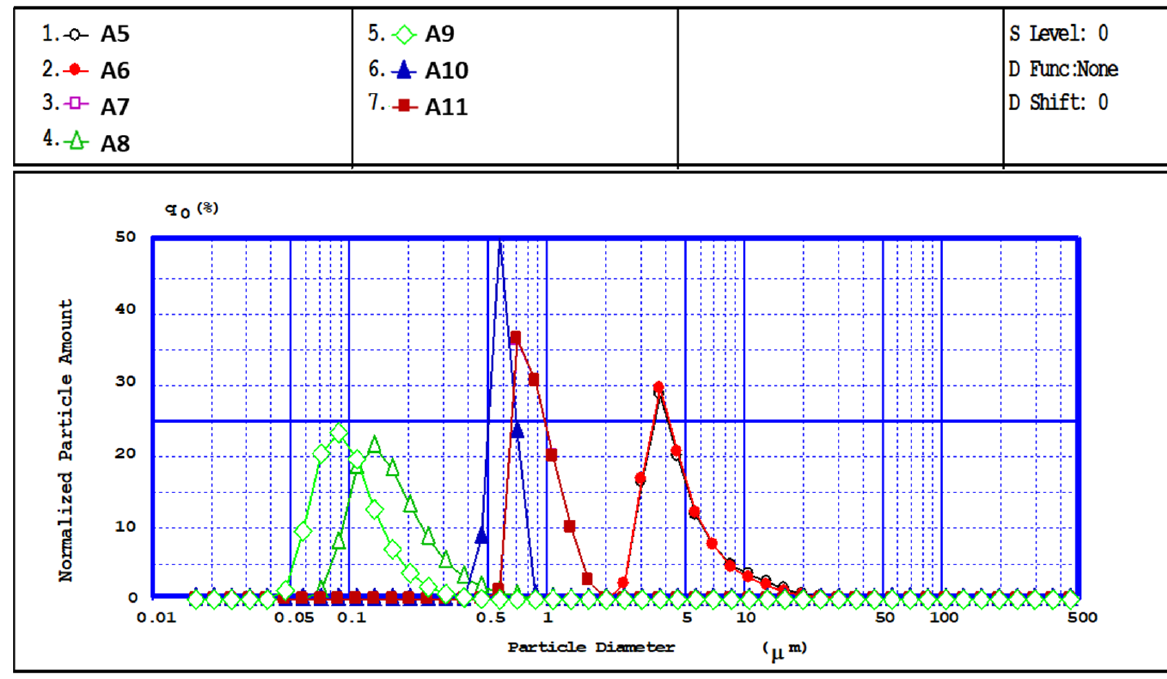
Figure 6. Granulometric distribution curves of CPH.